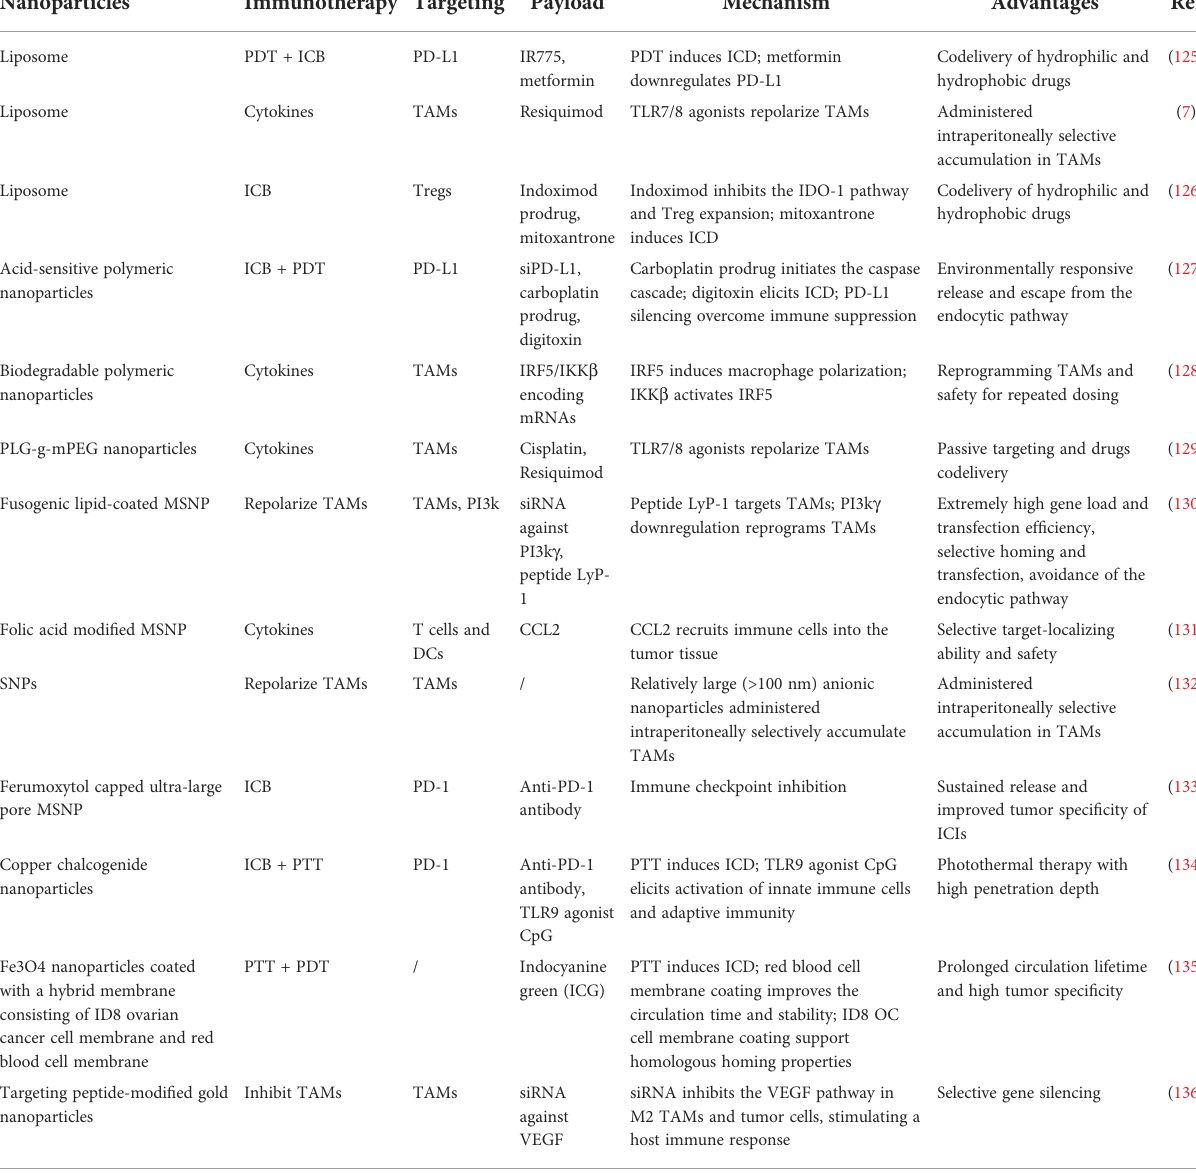
TABLE 2 Nanoparticles for regulating TIME and improving